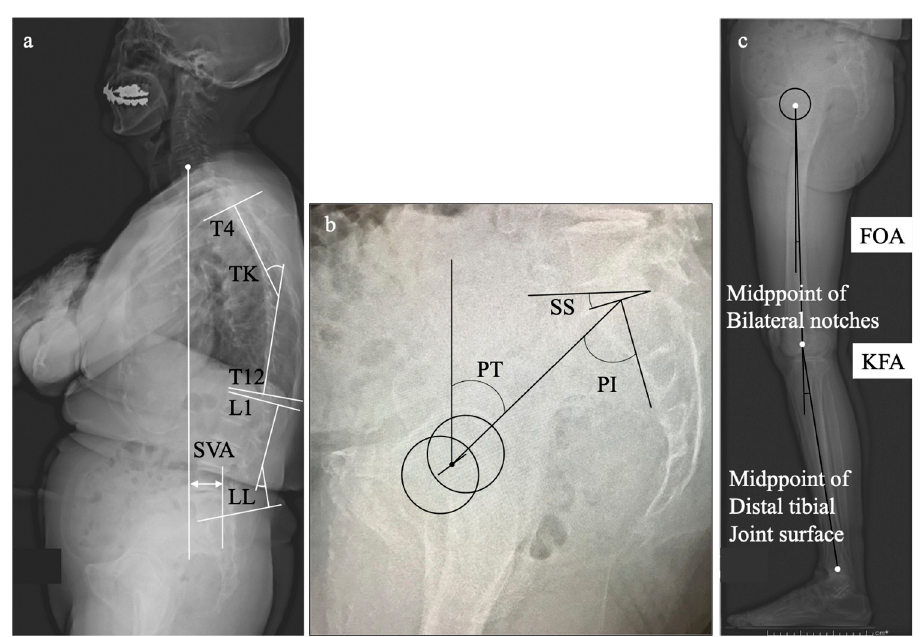
Fig 1. Sagittal alignment parameters in the standing position. Spinal parameters, TK (thoracic kyphosis), LL (lumbar lordosis), and the SVA (sagittal vertical axis), were measured on a lateral whole-spine radiograph (a). Pelvic parameters, the PT (pelvic tilt), SS (sacral slope), and PI (pelvic incidence), were measured (b). Lower limb parameters, the FOA (femur obliquity angle) and KFA (knee flexion angle), were measured (c).